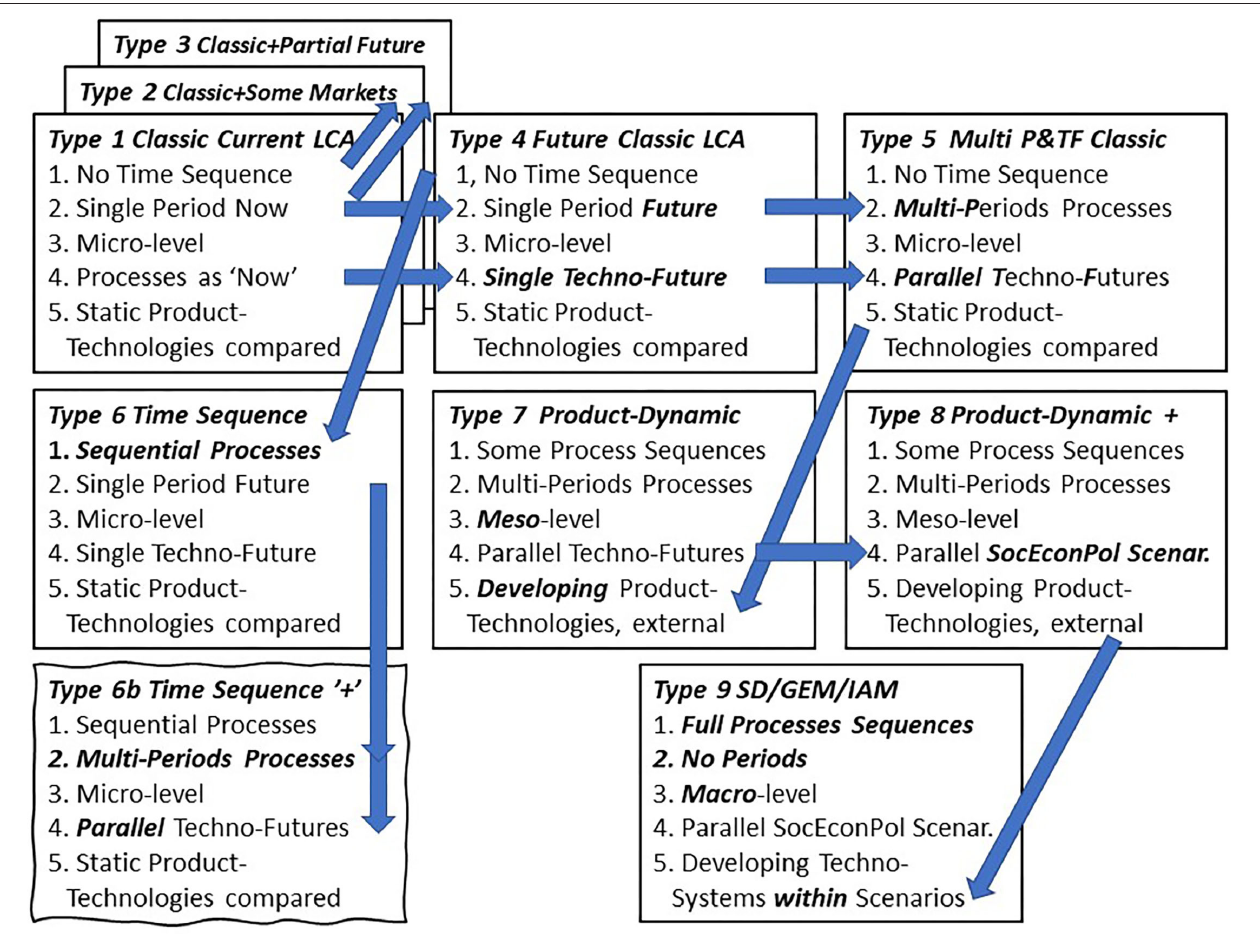
FIGURE 1 | Nine types of product-technology models presented as stepwise evolving (blue arrows) from Classic LCA models. For each type the five basic model characteristics are specified (discussed in section Basic Model